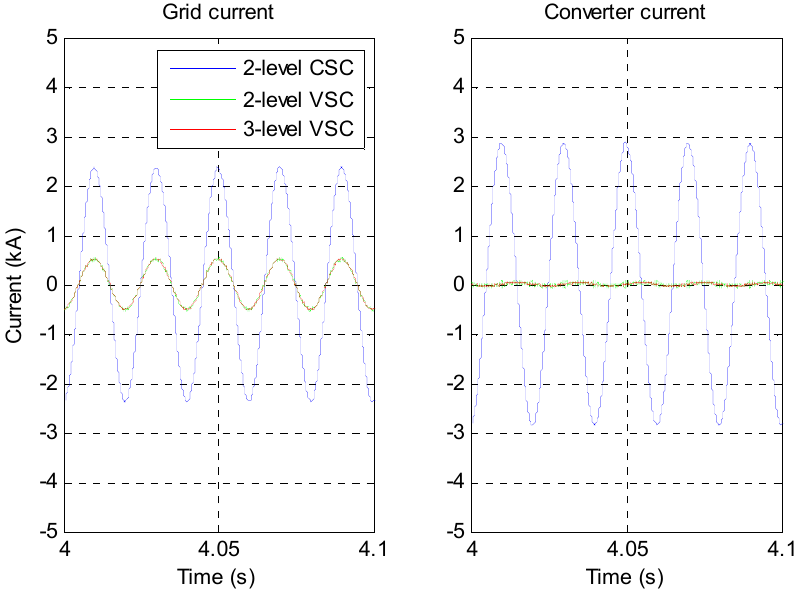
Figure 19. Grid current and converter current after the grid filter in each system.